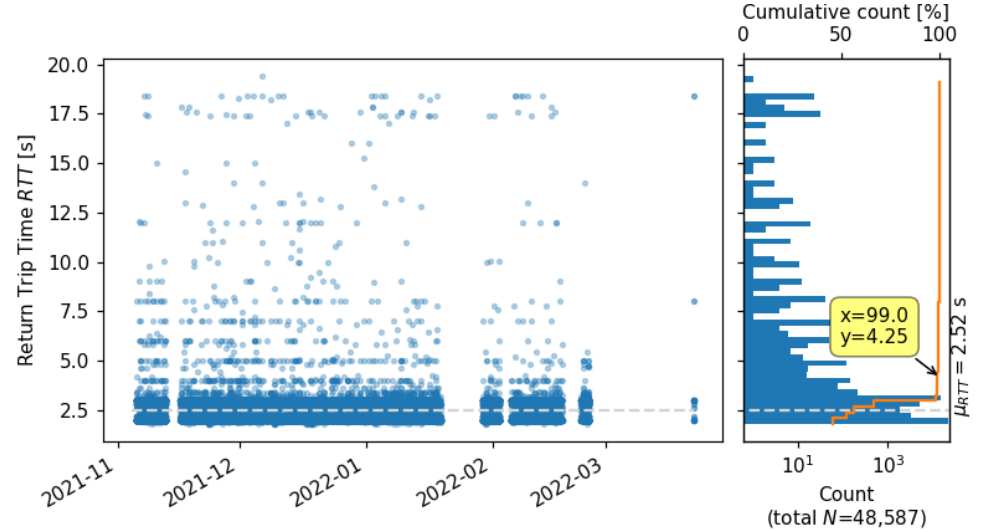
Figure 6. RTT via the full communication